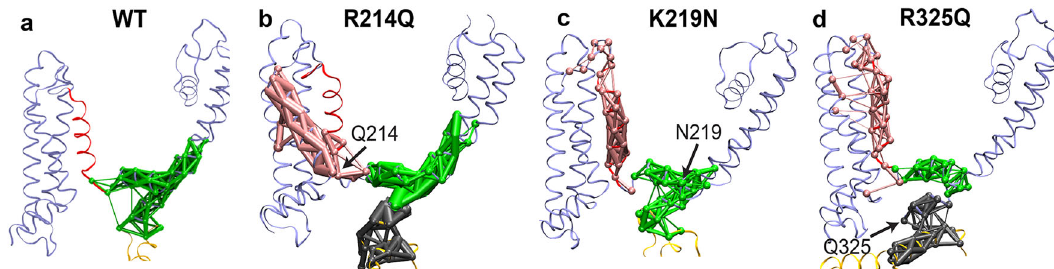
Fig. 6 Charge-neutralizing mutations of potential PIP 2 binding residues in Site-O4 disrupt the correlated motions of the VSD and the S6 gate of K v 7.2 channels. Network-based community analysis in WT ( a ) and mutant K v 7.2 channels containing R214Q ( b ), K219N ( c ), and R325Q ( d ) mutations in Site- O4. A community represents a set of residues that move in a correlated manner during the MD simulations. The thickness of the edges between the amino acids within each community corresponds to the strength of correlation between them. The network analysis was performed after combining all 3 independent simulation trajectories. a Binding of PIP 2 at Site-O4 in the WT channel results in correlated motions of the VSD (the S4 and the S4-S5 linker) and the gate S6, highlighted by a single community in green. b Introduction of the R214Q mutation leads to uncorrelated motions of the VSD and the gate, highlighted by 3 separate communities colored in pink, green, and gray. c Introduction of the K219N mutation leads to uncorrelated motions of the VSD and the gate, highlighted by the smaller community in green and the emergence of an additional community colored in pink. d K v 7.2-R325Q channels displayed weaker correlated motions of the S4 and the S4-S5 linker, and the decoupling of the S6 of the pore domain from the VSD, highlighted by the much smaller community in green and the emergence of 2 additional communities colored in pink and gray.